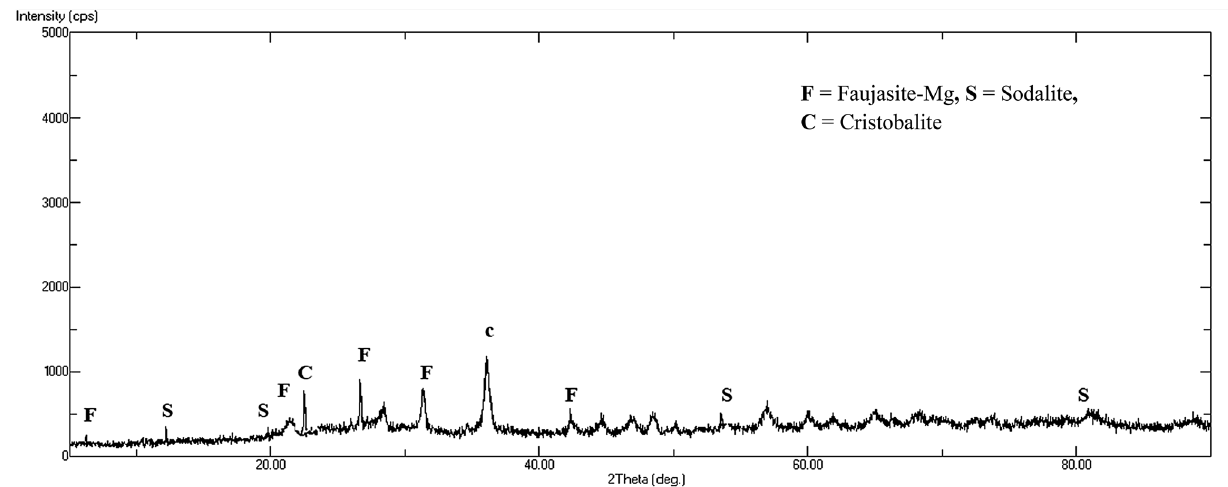
Fig. 6 PXRD spectrum of MgFZBFA showing constituent mineral phases